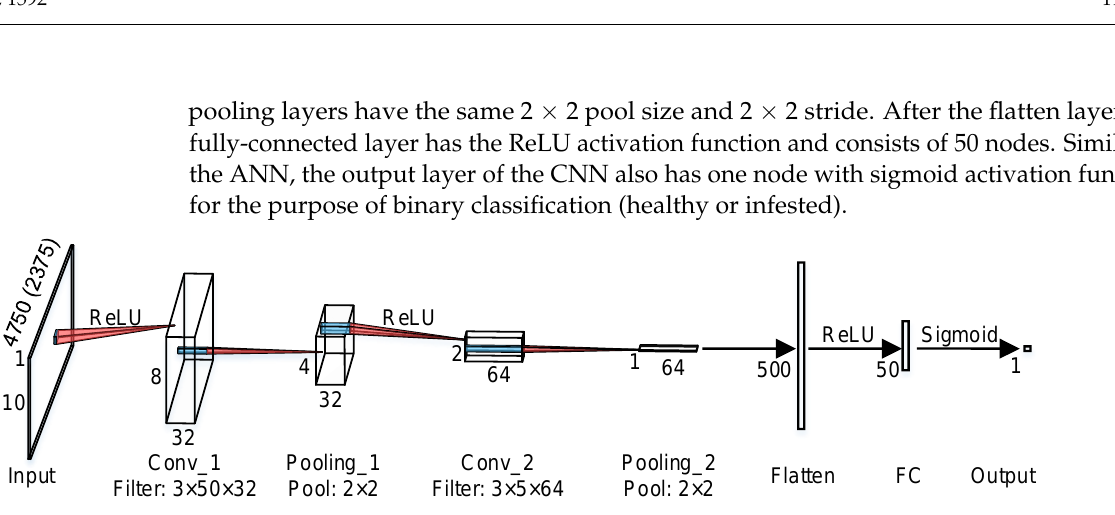
Figure 11. The CNN structure for detecting the RPW infestation using the temporal/spectral data. Conv: convolutional; FC: fully-connected.